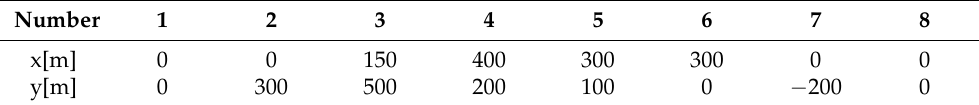
Table 3. Planned waypoints.